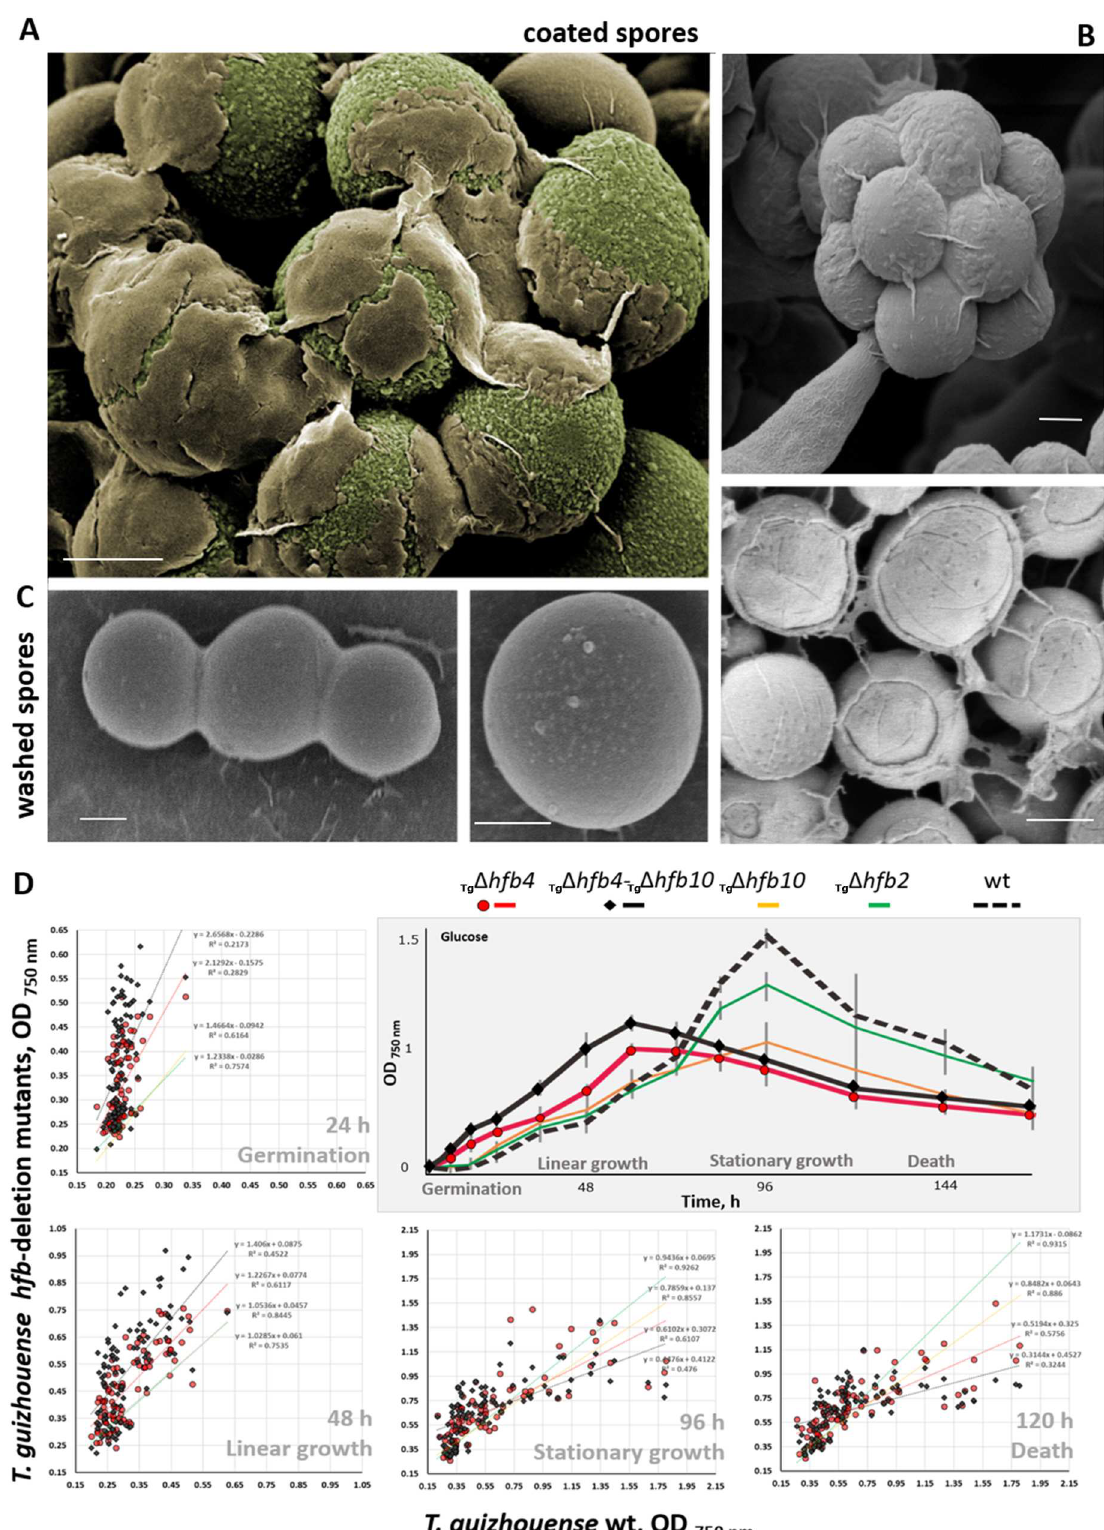
Fig 7. The water-soluble HFB-enriched coat of Trichoderma spores and its role in spore germination. (A) Premature Tg conidia with an uneven coat of extracellular proteins. Note: image was artificially colored for clarity. (B) A mature spore clump and spores evenly